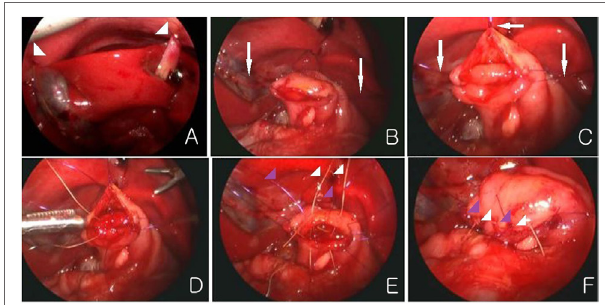
FigUre 1 | (a) Transabdominal sutures are placed through the falciform ligament and gall bladder (arrow head). (B,c) Two ends of the corners and the middle portion of proximal duodenum are led out through the skin for traction (white arrow). (D–F) The posterior and anterior anastomosis is made. Vicryl (white color) and PDS (purple color) are used alternately.